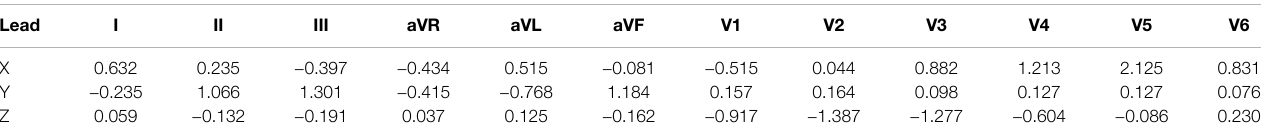
TABLE 3 | Leading vectors for deriving a 12-lead electrocardiogram from the Frank XYZ signal.